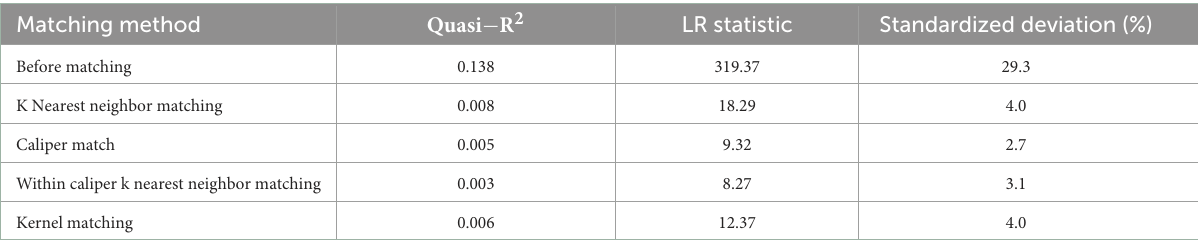
TABLE 5 Results of balance tests before and after matching of health awareness explanatory variables.